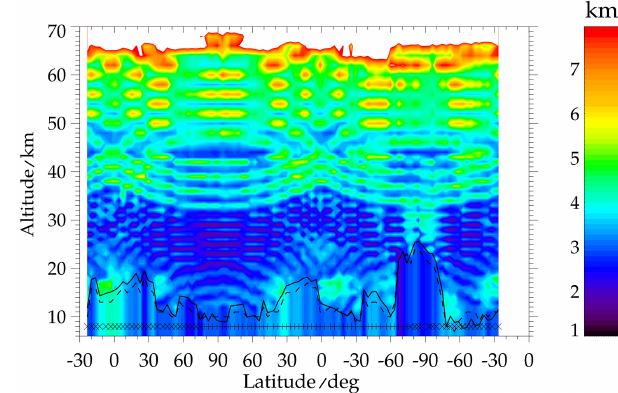
Figure 2. Vertical resolution of CH 4 profiles along one orbit. The oscillation nature of the altitude resolution is caused by the fact that the altitude resolution is better at a tangent altitude than between two adjacent tangent